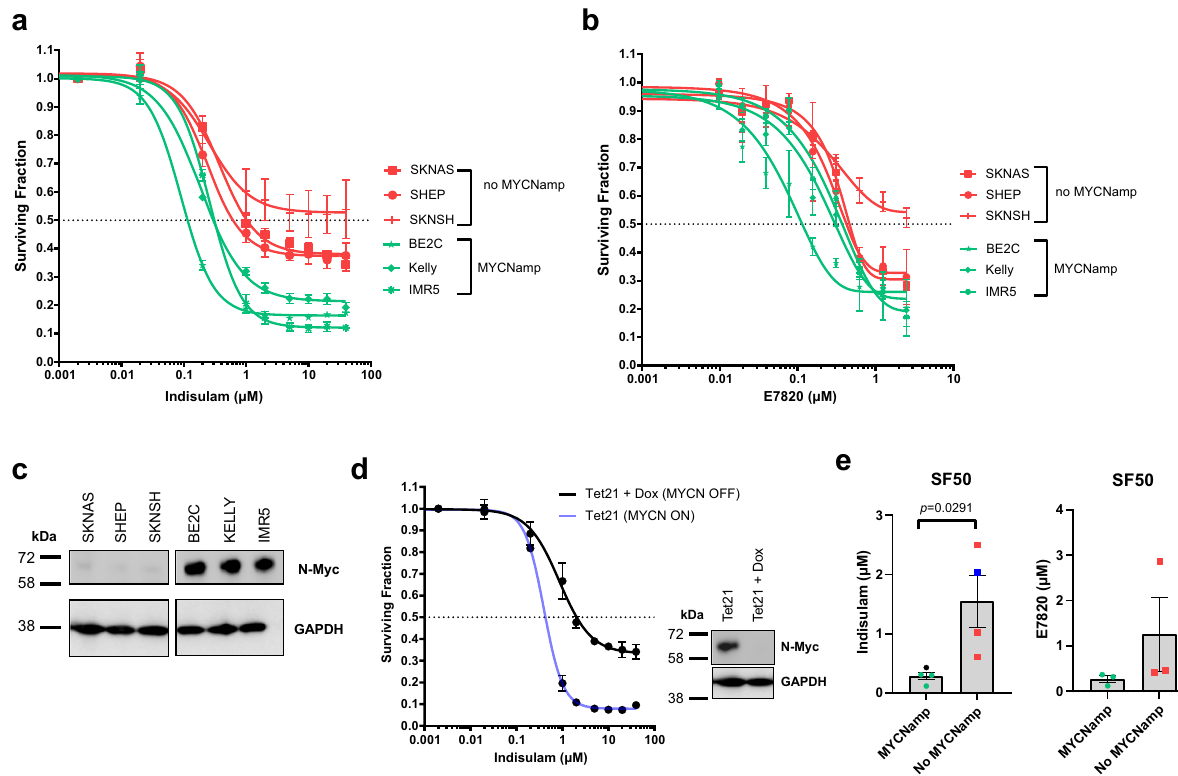
Fig. 9 MYCN expression is a determinant of indisulam sensitivity in neuroblastoma. a , b Dose – response curve in six neuroblastoma lines, three without and three with MYCN ampli fi cation of indisulam ( a ) or E7820 ( b ). Cell survival was determined after 72 h with Cell-Titre Glo ( n = 3 independent experiments). c Western blot for N-Myc and GAPDH on six neuroblastoma lines. d Dose – response curve in Tet21 MYCN ON or MYCN OFF (treated with 1 µ g ml − 1 doxycycline) of indisulam. Cell survival was determined after 72 h with Cell-Titre Glo ( n = 3 independent experiments). Western blot of n-Myc and GAPDH. Blot is representative of n = 3 independent experiments. e 50% Surviving Fraction (SF50) of neuroblastoma cells (dots represent mean SF50 of n = 3 independent experiments) treated with indisulam ( n = 8 cell lines, 3 MYCN amp, 3 no MYCN amp, 2 Tet21) or E7820 ( n = 6 cell lines, 3 MYCN amp, 3 no MYCN amp). Data are presented as mean ± SD ( a , b , d ) or SEM ( e ). Statistical analysis in e was determined by a two-tailed unpaired t -test. Source data is provided as a Source Data File. Table 1 PCR primer sequences for end-point